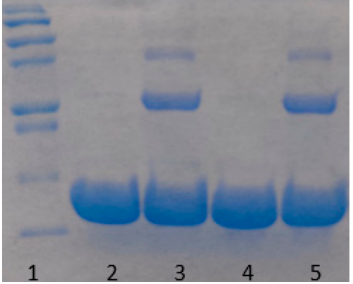
Figure 10. SDS-PAGE gel image for Lysozyme (30 mg / mL) incubated at room temperature for three weeks prior running the gel. Left to right: 1. Ladder (From the bottom 10, 15, 20, 25, 37, 50 kDa). 2. Sample unheated. 3. Sample heated to 80 °C. 4. Sample unheated, then incubated at 95 °C for 5 min prior running the gel. 5. Sample heated to 80 °C, then incubated at 95 °C for 5 min prior running the gel.